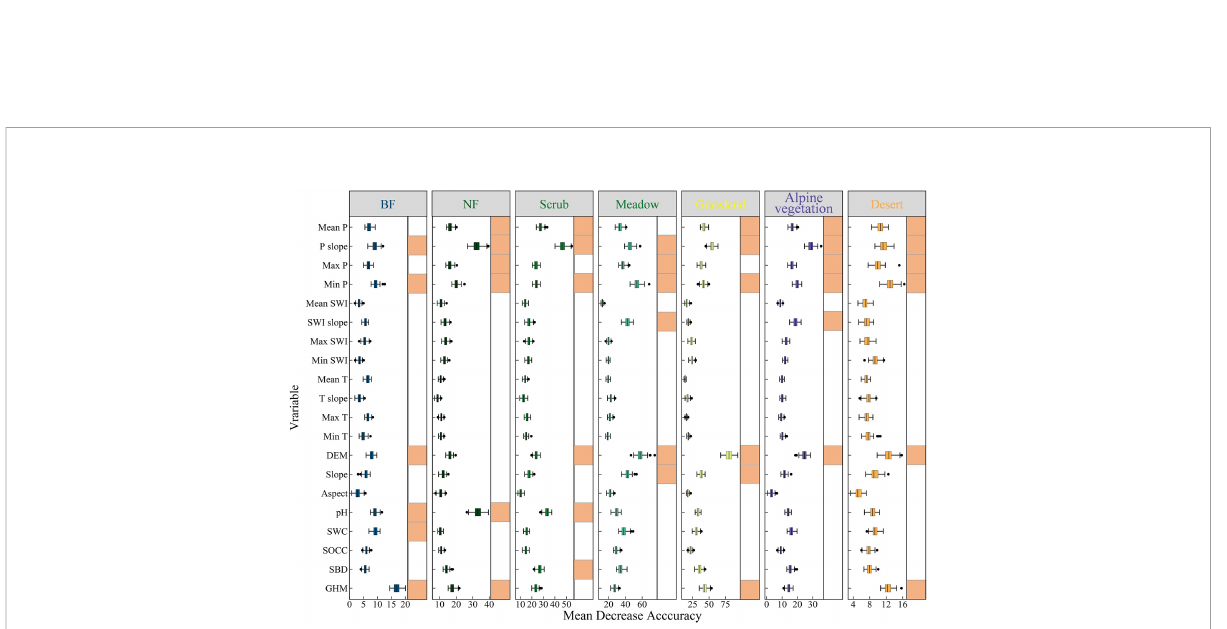
FIGURE 7 Feature importance of seven vegetation types. The orange square after a variable is used to indicate that the variable is ranked in the top 6 out of 20 variables in terms of feature importance.